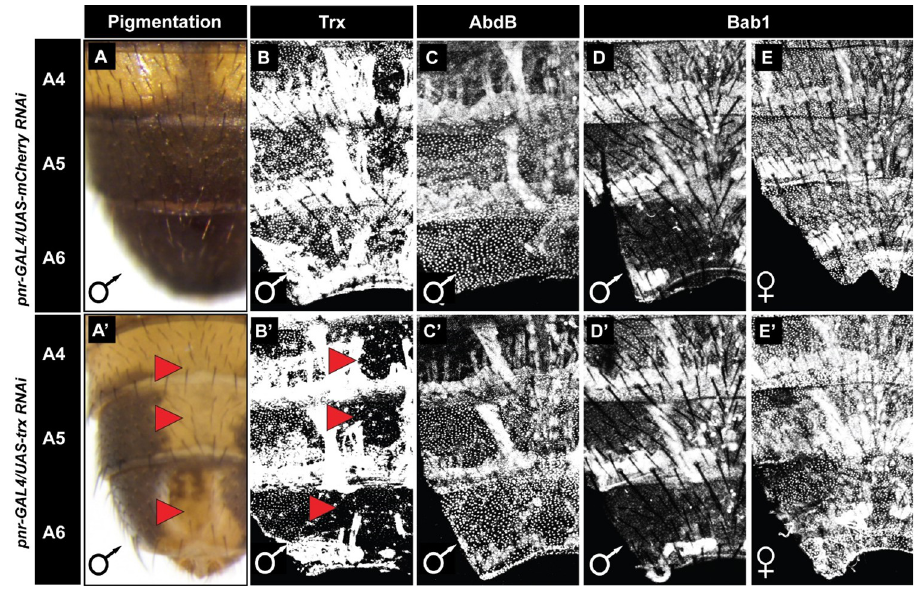
Fig 6. Reduced Trithorax expression has little to no effect on pupal abdominal expression of Abd-B and Bab1. (A-E) Specimens for which RNAi targeted the negative control mCherry gene in the dorsal abdomen midline region. (A’-E’) Specimens for which RNAi targeted the trithorax gene in the dorsal abdomen midline region. (A) While mCherry RNAi had no effect on adult male tergite pigmentation, (A’) a conspicuous loss of pigmentation occurred following RNAi for trx . (B) While mCherry RNAi had no effect on Trx protein expression in the abdominal epidermis, (B’) a conspicuous loss of Trx expression was seen in the midline region in response to trx RNAi. Neither (C) mCherry RNAi nor (C’) trx RNAi had a noticeable effect on the A5 and A6 segment expression of Abd-B. In addition to the expected Abd-B nuclear expression, in these specimens some non-specific expression was observed in muscle tissue. Neither (D and E) mCherry RNAi nor (D’ and E’) trx RNAi caused a noticeable difference in the expression of Bab1. Red arrowheads point to abdomen regions where pigmentation or protein expression was altered compared to the